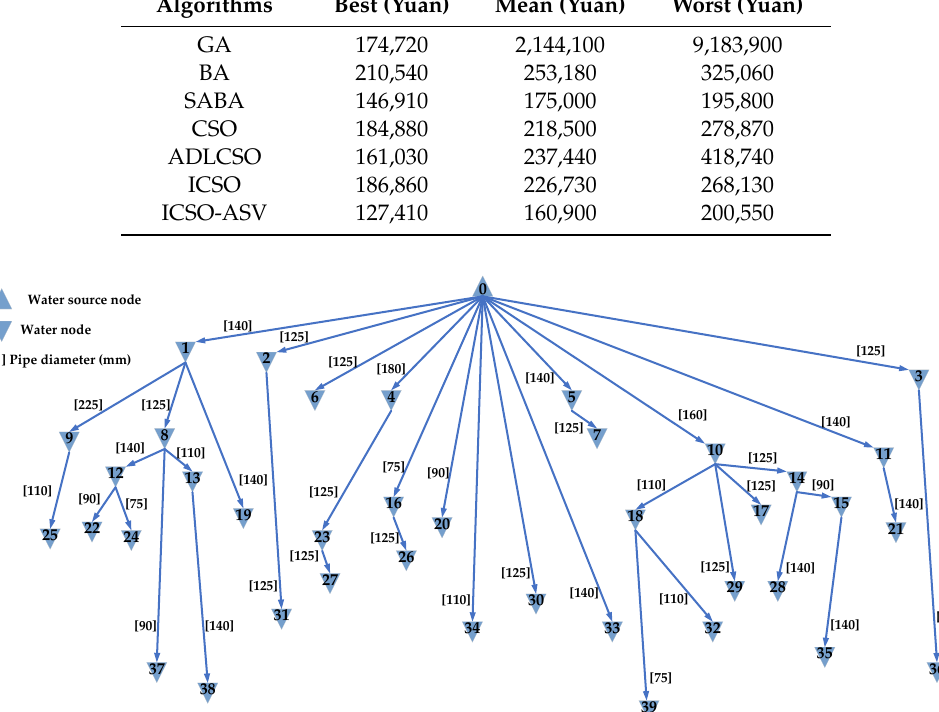
Figure 5. Optimal design results for the pipe network based on the ICSO-ASV algorithm (40 nodes, 2D).